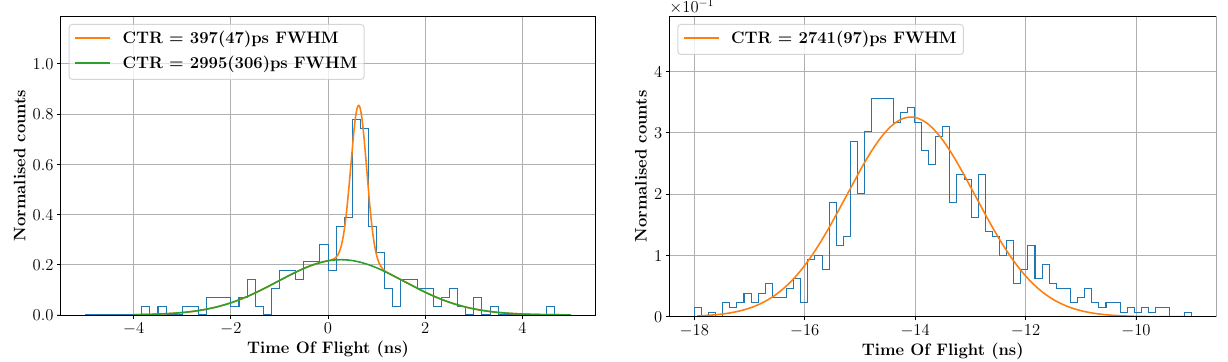
Figure 8. On the left, TOF distribution obtained from the irradiation of the 5 mm target. The gaussian peak with 397 ps (FWHM) corresponds to PGs generated by protons traversing the beam monitor; the large background signal corresponds to PGs generated by protons passing by the diamond detector. On the right, the TOF distribution obtained from random coincidences between the diamond and the PG detectors confirms the origin of the background on the left plot: it is a measure of the bunch-induced time